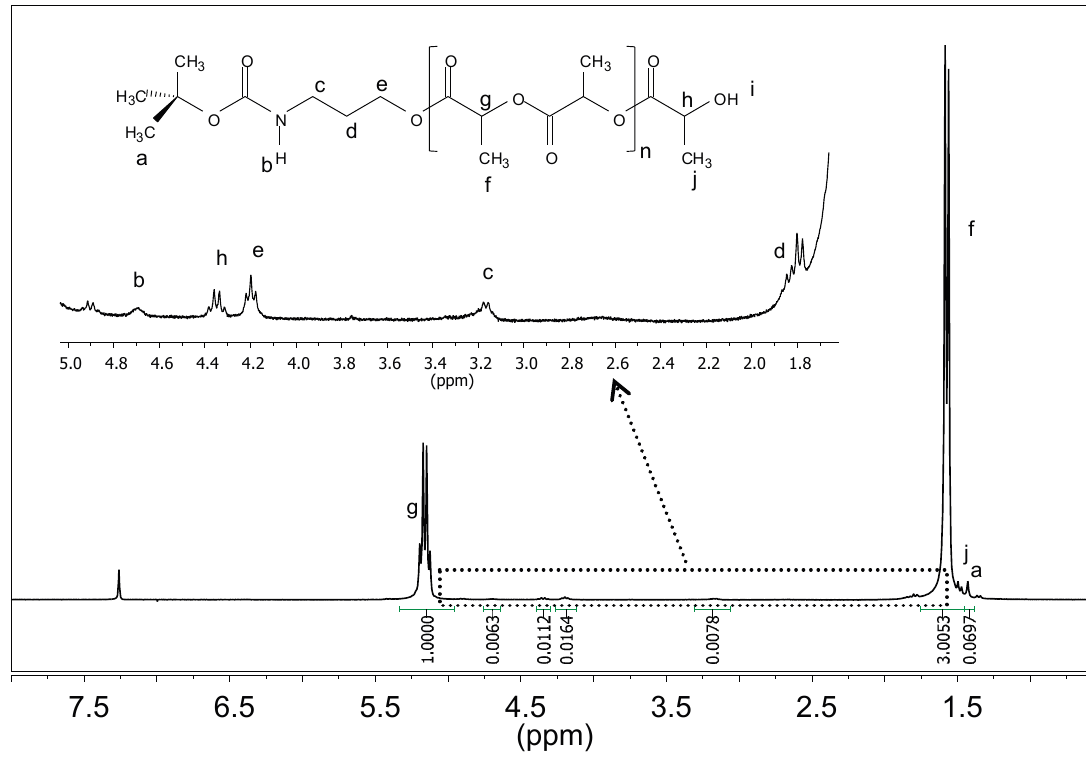
sample bearing—NHBoc end groups with 100 ). 3